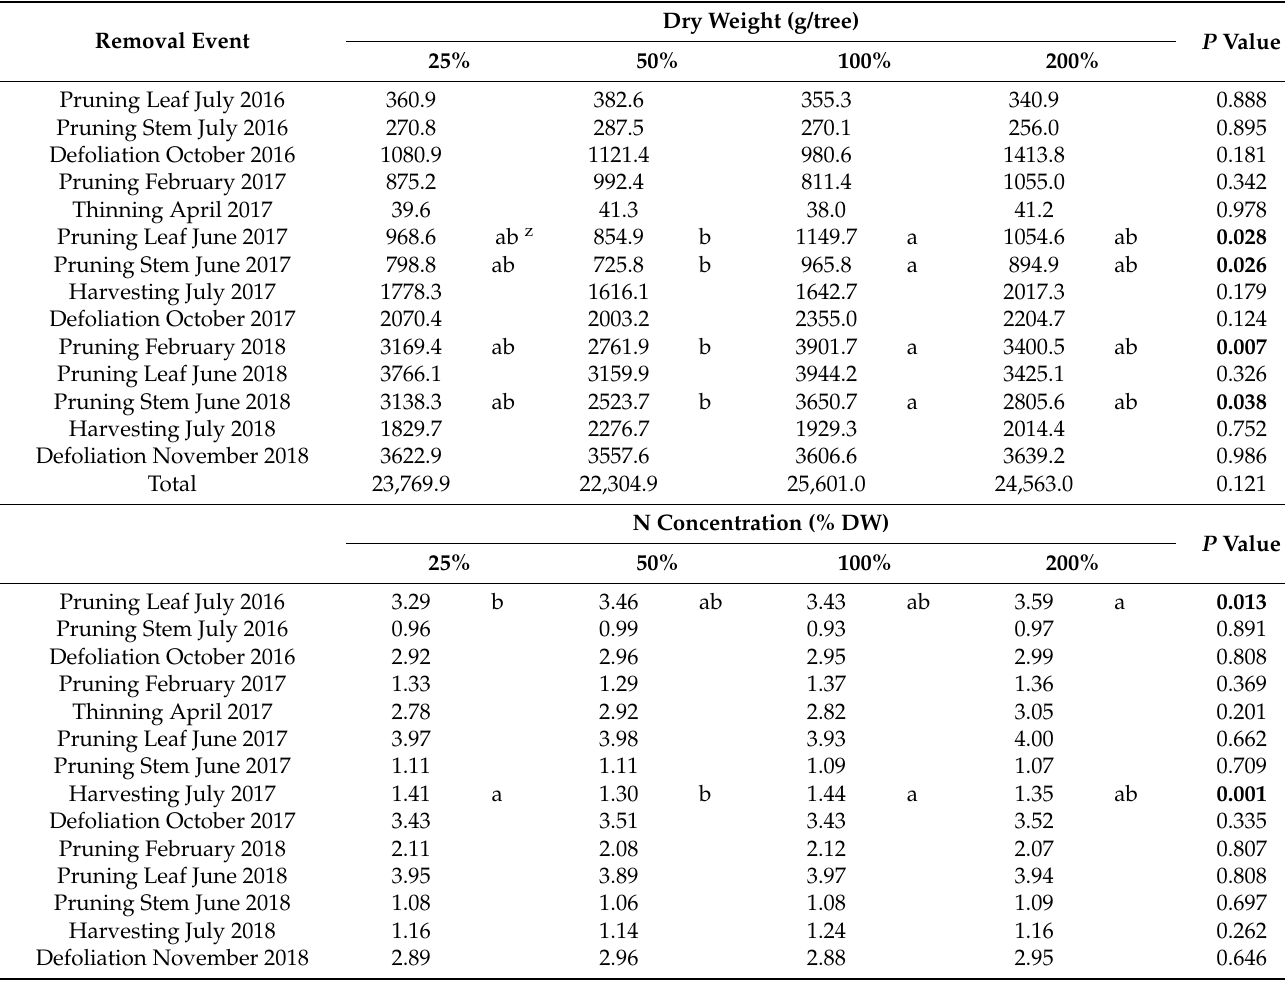
Table 4. Dry weight (DW) and N concentration in the different removal events for the different fertilizer levels (25, 50, 100, and 200%) for trees of “Julyprince” peaches in 2016, 2017, and 2018. Removal